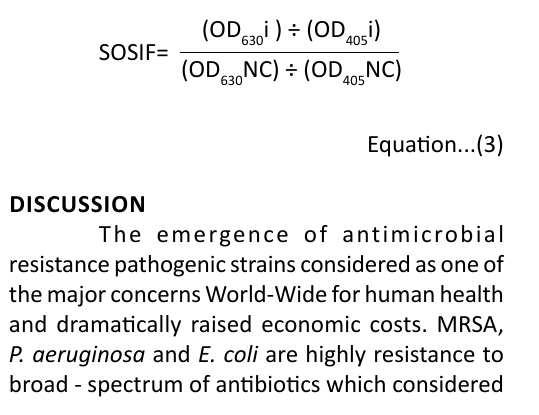
Fig. 7. Antibacterial Activity of TiO and E.